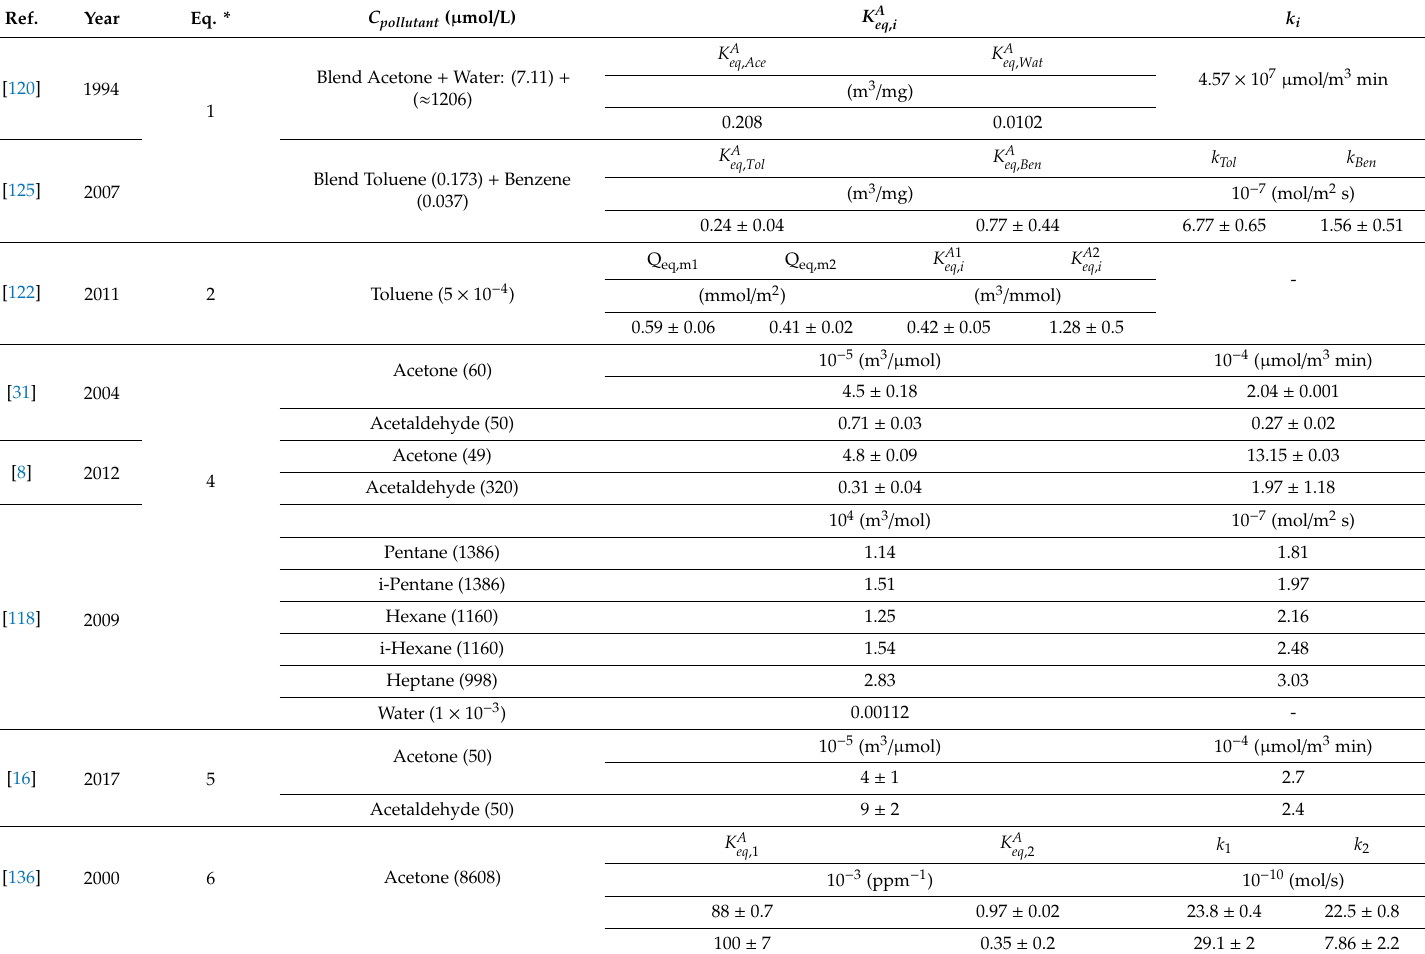
Table 4. Comparison of adsorption and kinetic constants for TiO 2 -based photocatalytic conversion of VOCs.